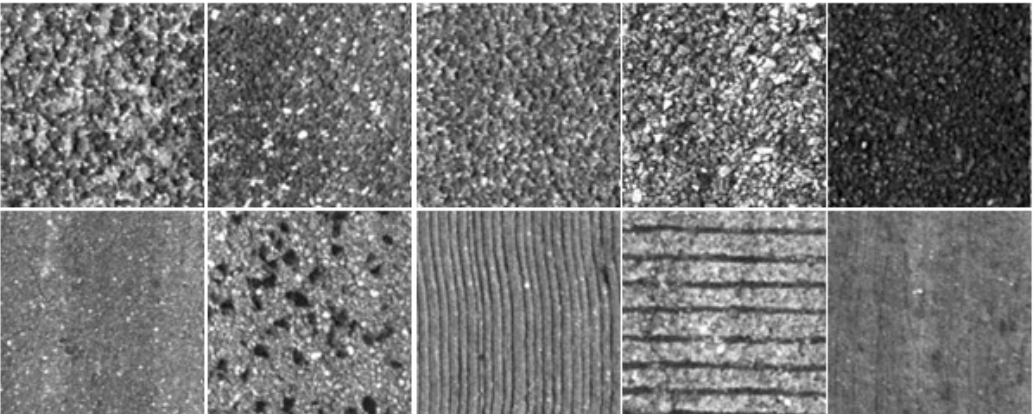
Figure 8. Surface classes: seven classes are bituminous (asphalt) materials and three are concrete.